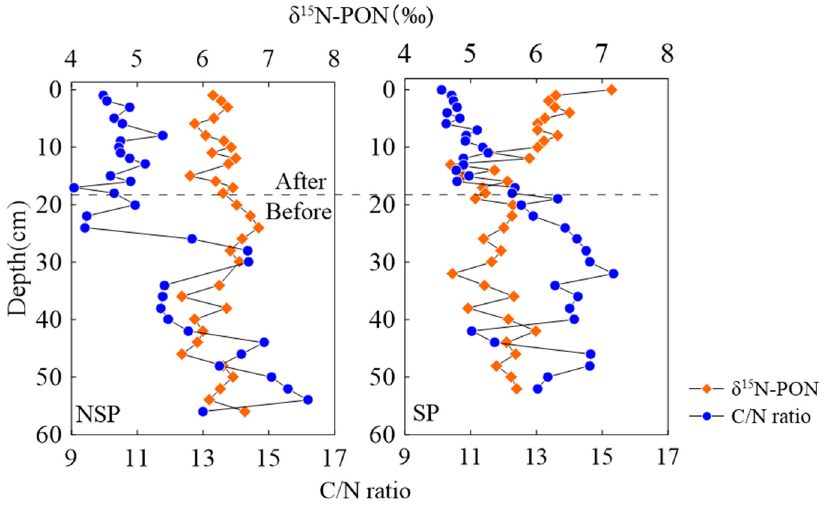
Figure 5. Characteristics of the vertical distribution of δ 15 N-PON and C/N ratio in particulate organic matter.